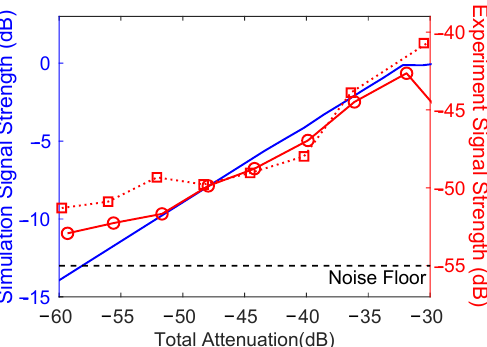
Figure 5. SM signal strength vs. attenuation. Red curves are the experimental result (circles—DFB, squares—VCSEL), and the blue curve is the simulation result.